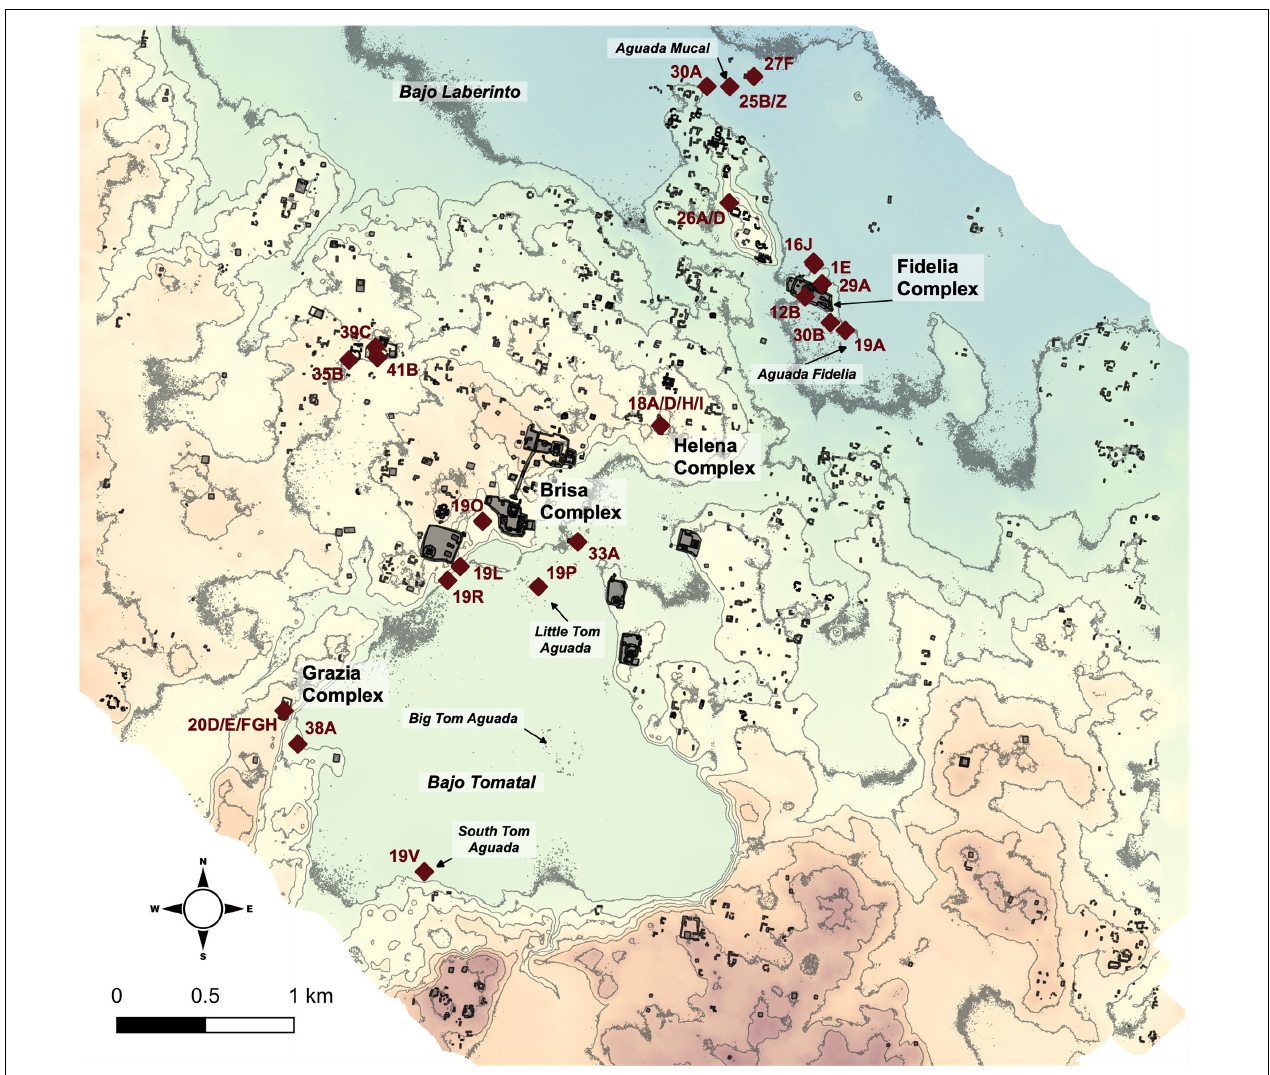
FIGURE 2 | Map of Yaxnohcah showing the location of the structures, operations, and features mentioned in the